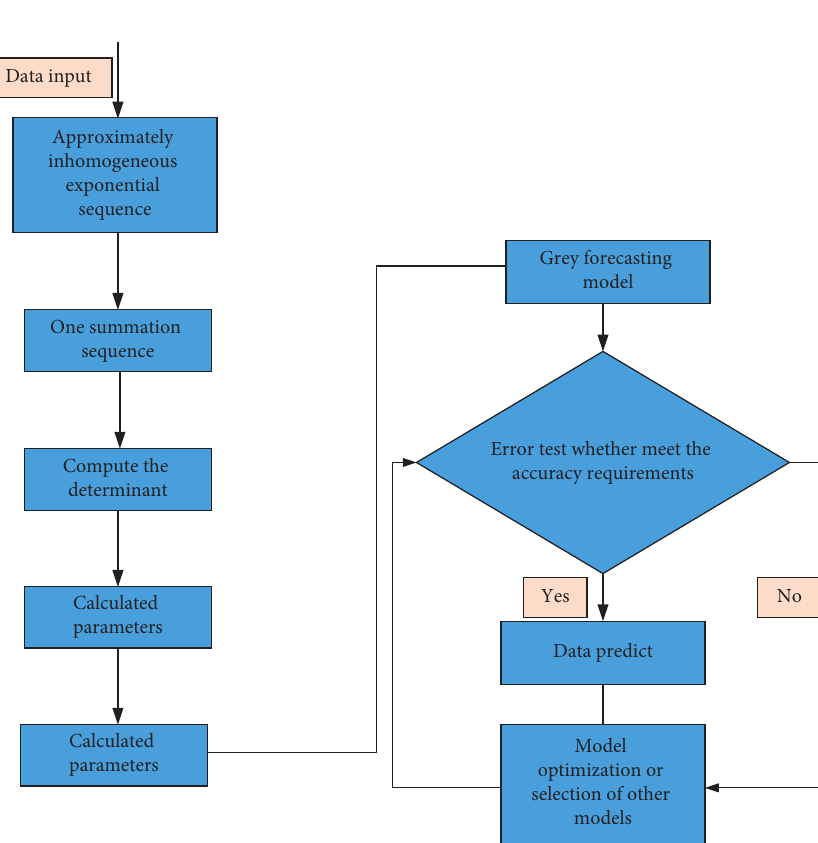
Figure 4: Grey prediction model